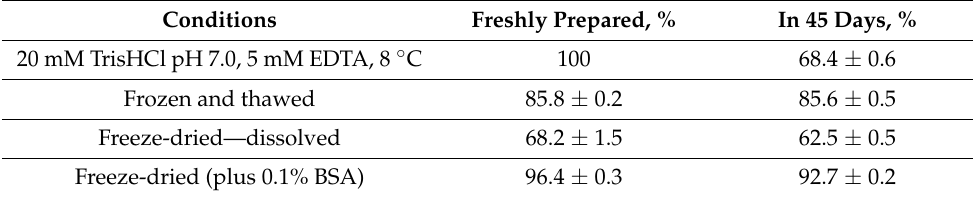
Table 1. Residual active FMZ-apoCBP as determined by NanoLuc bioluminescence.